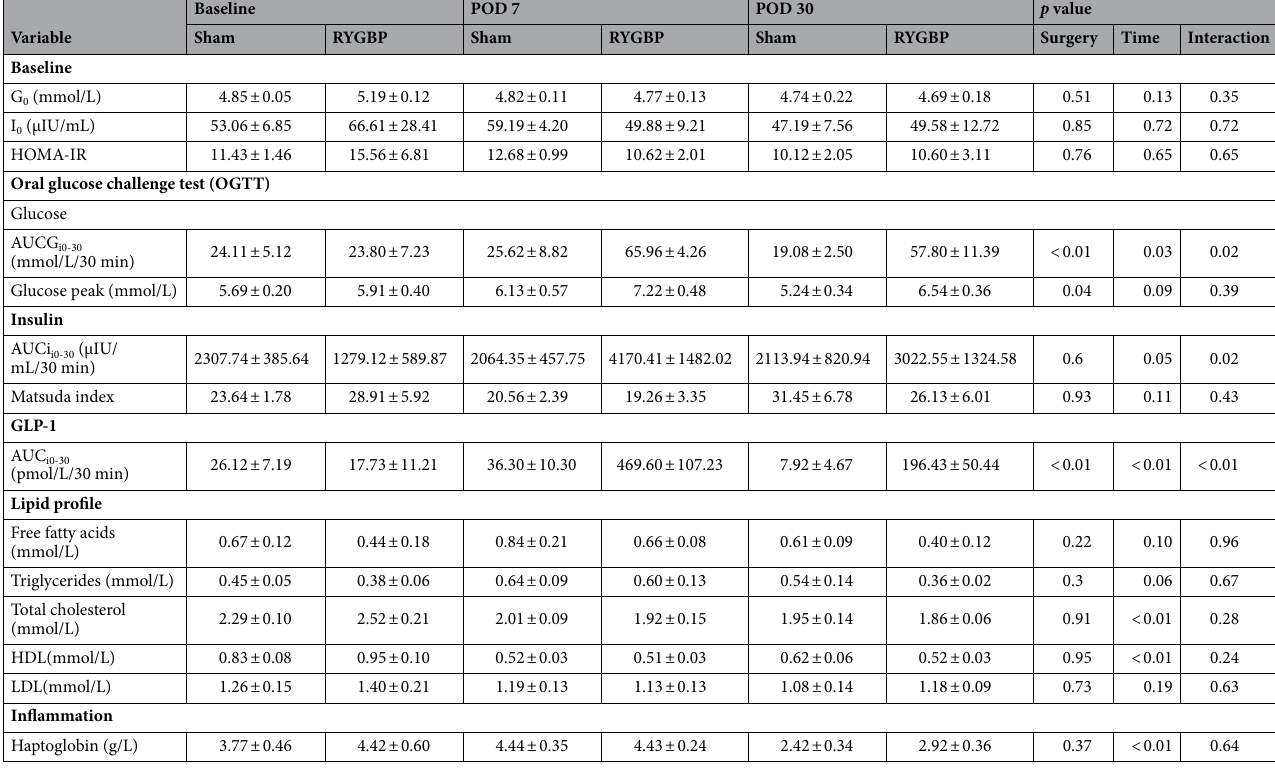
Table 1. Metabolic parameters before and after surgery in RYGBP and sham minipig groups.